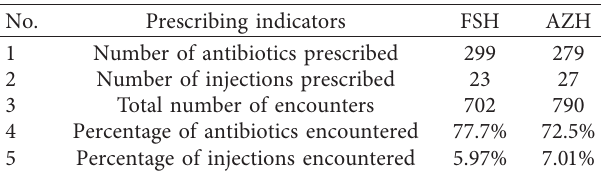
Figure 1: Number of drugs per prescription at (a) FSH and (b) AZH, from October 11 to November 30, 2019, northwest Ethiopia. Table 3: Percentage of antibiotics and injections encountered from October 11 to November 30, 2019, at FSH and AZH, northwest